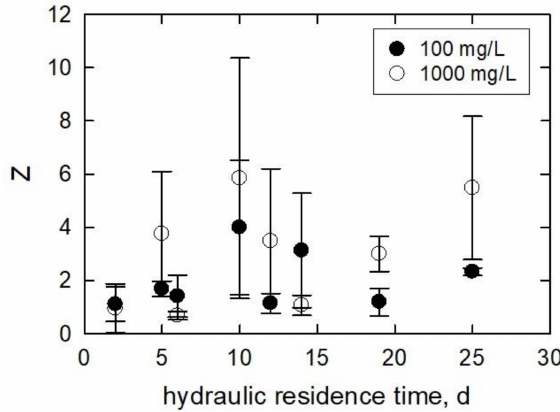
Figure 8. Normalized specific lipid peroxidation ( Z ) plotted against the hydraulic residence time of the